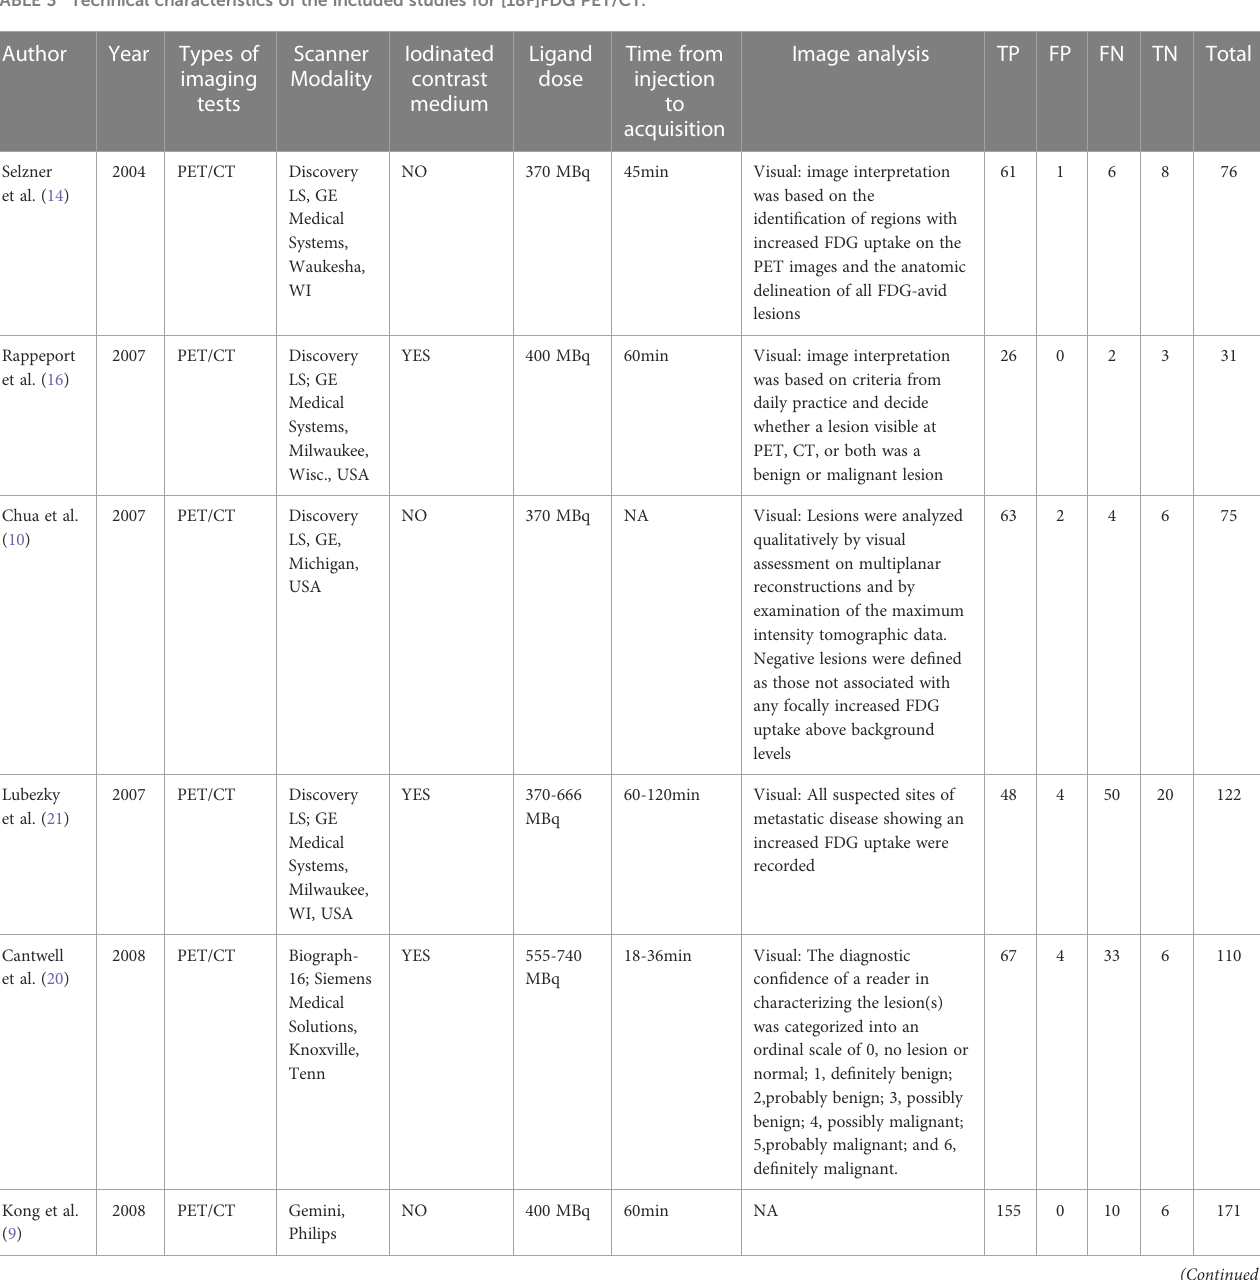
TABLE 3 Technical characteristics of the included studies for [18F]FDG PET/CT.